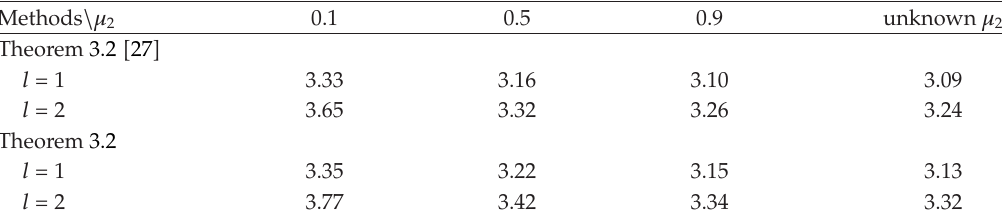
Table 4: Calculated MAUBs τ max for various l,μ 2 in Example 4.2. Methods \ μ 2 0 . 1 0 . 5 0 .